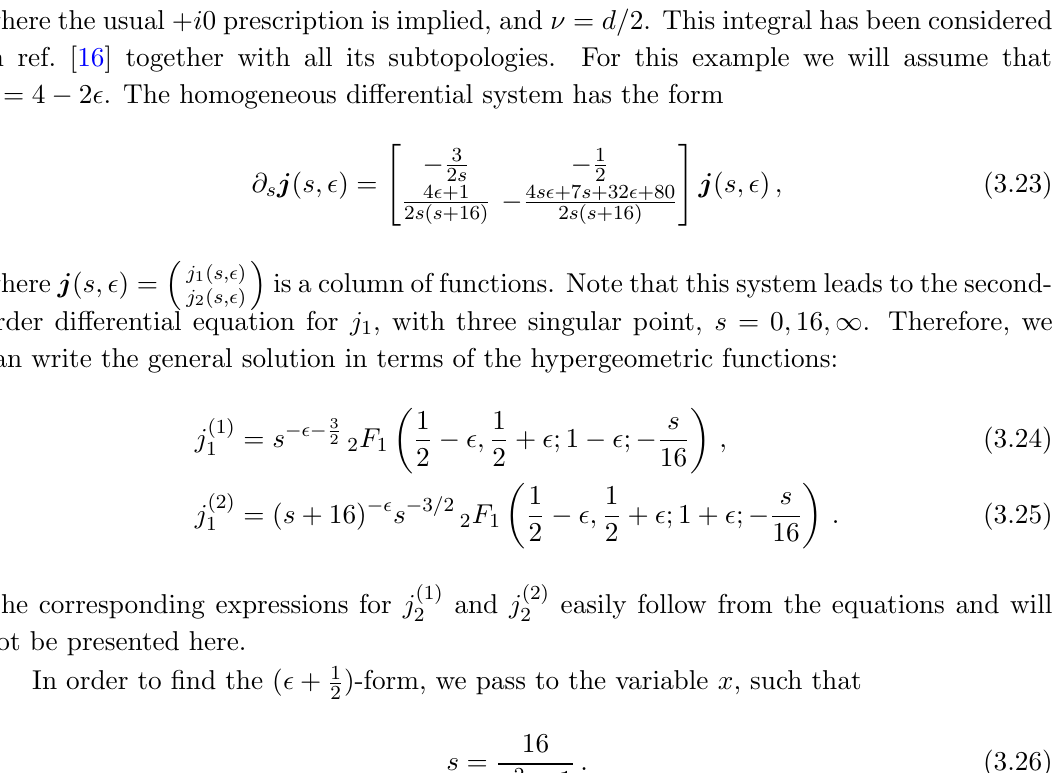
= k 2 = 0, q = k 1 + k 2 1 2